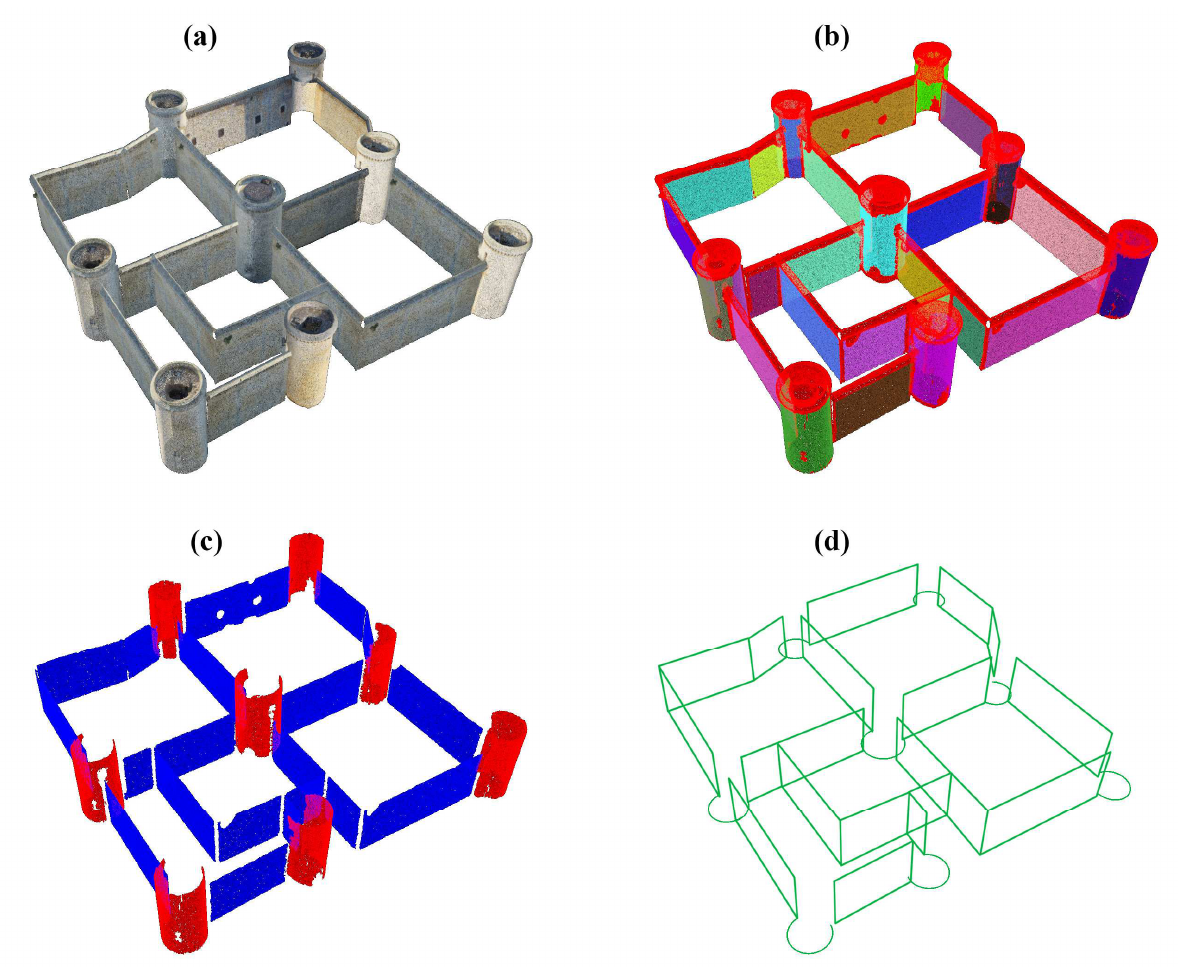
Figure 5: Synthetic point cloud. a) Pre-processed point cloud; b) segmented; c) Classified; d) Final